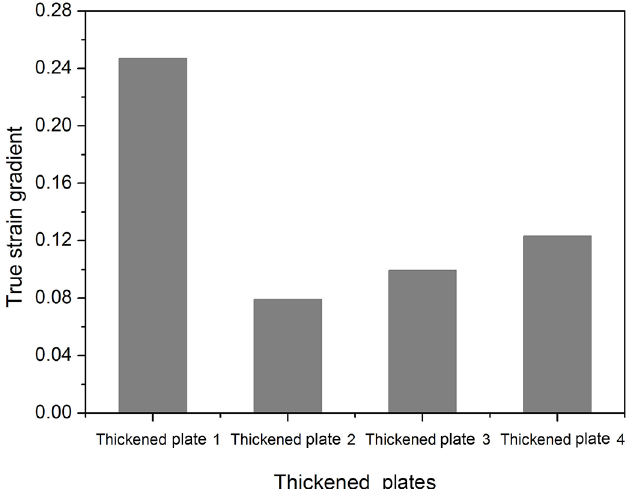
Fig. 15. True strain gradients between the external and the internal surface at the cup wall of square cups with various thickened plates.